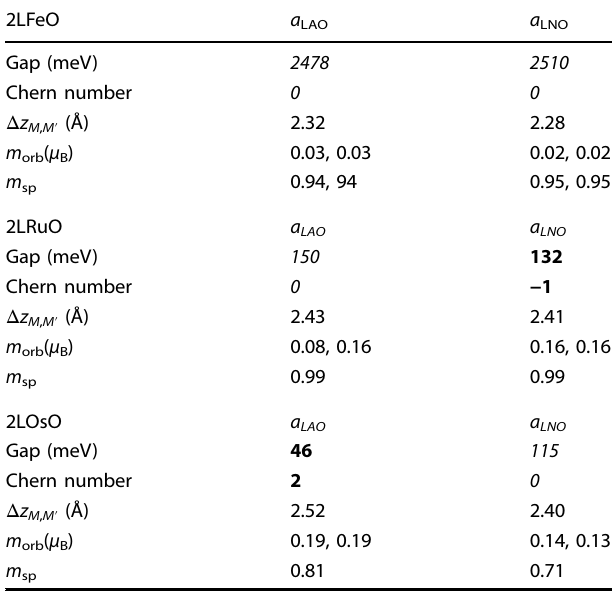
Table 1. Characteristics of the ground states of the d 5 buckled honeycomb systems 2LFeO, 2LRuO, and 2LOsO, fully relaxed ( P 1 symmetry) and including SOC, for each of the two lattice